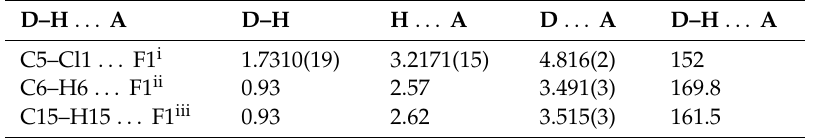
Table 2. Non-classical hydrogen and halogen bonding lengths [Å] for compound 3